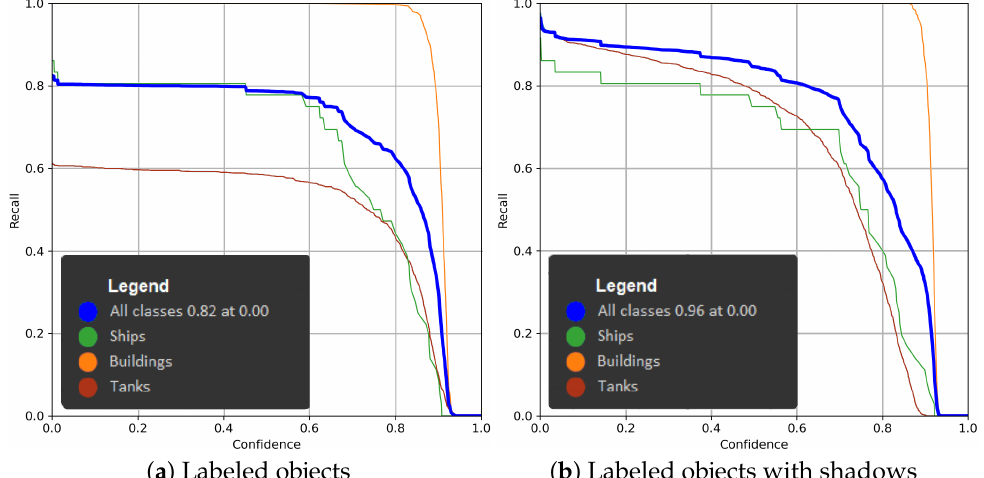
Figure 7. R curve for networks with different preprocessing